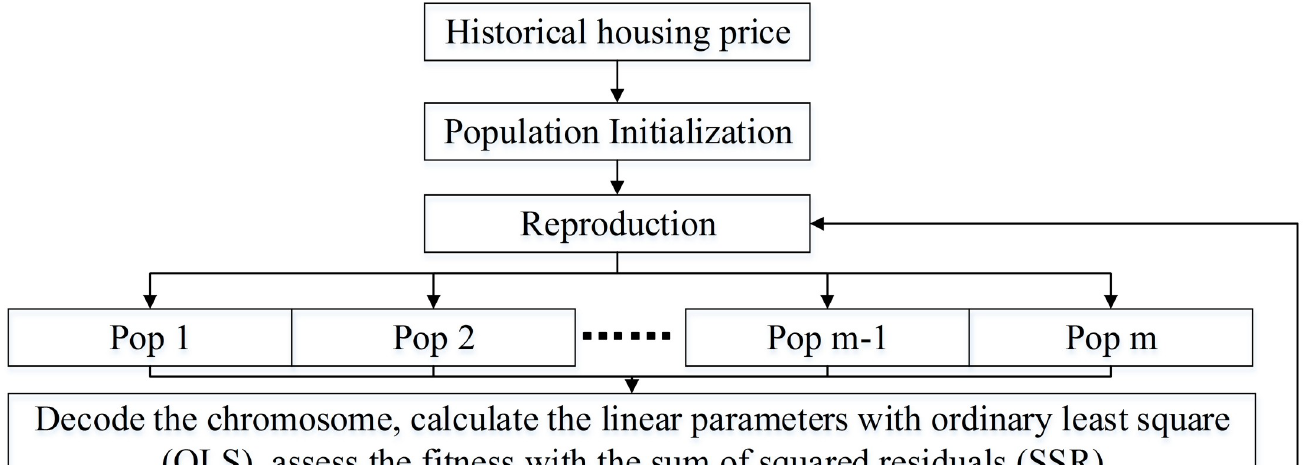
Fig 5. Flowchart of